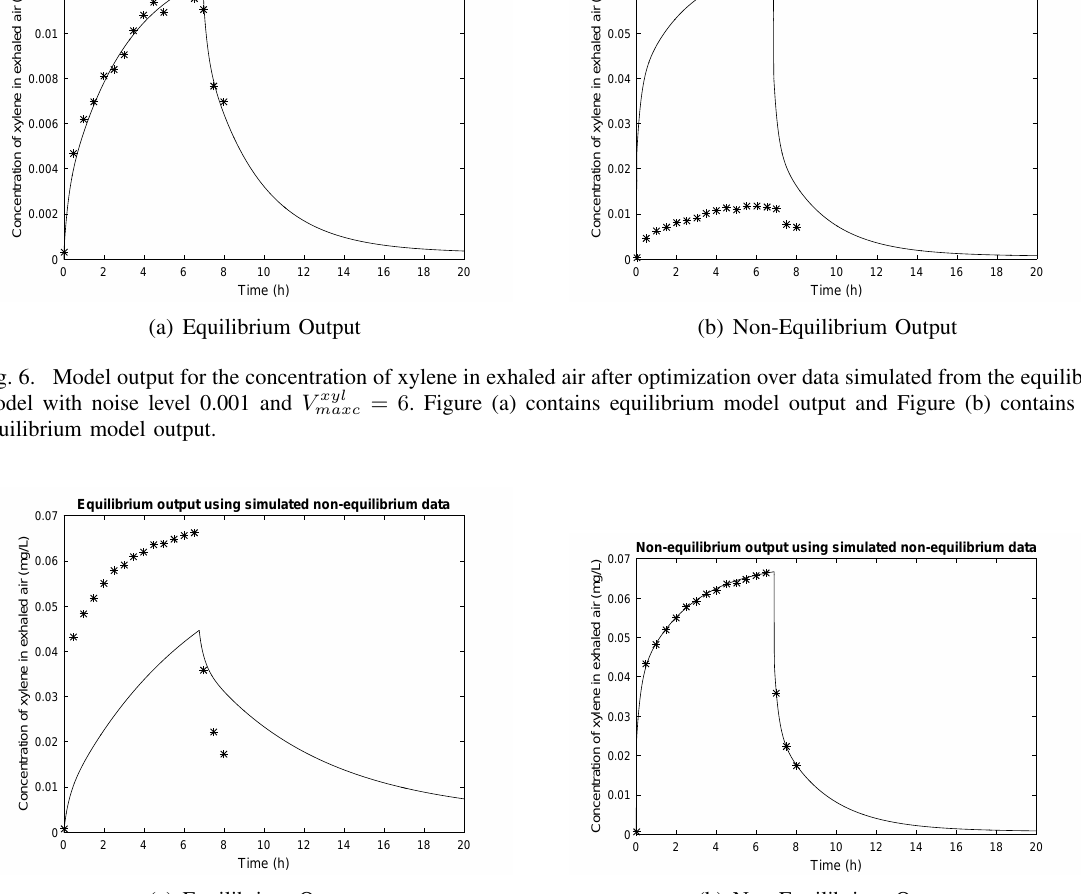
(b) Non-Equilibrium Output Fig. 7. Model output for the concentration of xylene in exhaled air after optimization over data simulated from the non- equilibrium model with noise level 0.001 and V xyl maxc = 8 . Figure (a) contains equilibrium model output and Figure (b) contains non-equilibrium model